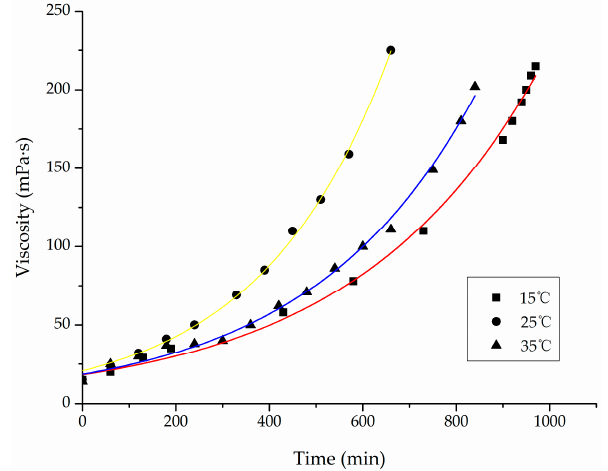
Figure 3. The viscosity-temperature-time curve of CW 6:1 slurry.